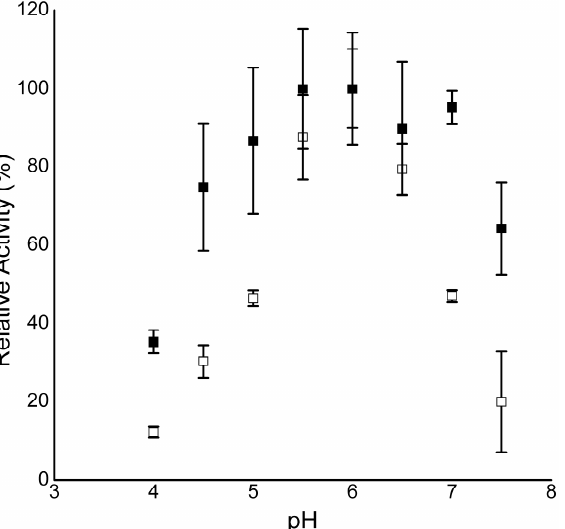
Figure 1. Effect of pH on the activity of free and immobilized ALDC at 37 ◦ C. ( (cid:3) ) Free and ( (cid:4) ) immo- bilized enzymes. Error bars represent the standard deviation from the mean of three independent experiments.